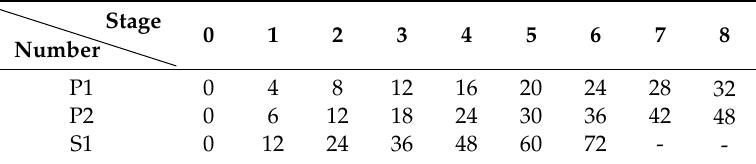
Figure 15. Electrochemical accelerated corrosion method: ( a ) Schematic diagram of corrosion circuit layout and the cross-section of the actual specimens; ( b ) the picture of corrosion in situ; ( c ) The defects after corrosion of the specimens. P1: the parallel wire strand made of seven steel wires; P2: the parallel wire strand made of 19 steel wires; S1: the steel strand. Table 3. The corrosion schedule of all specimens (unit: h).